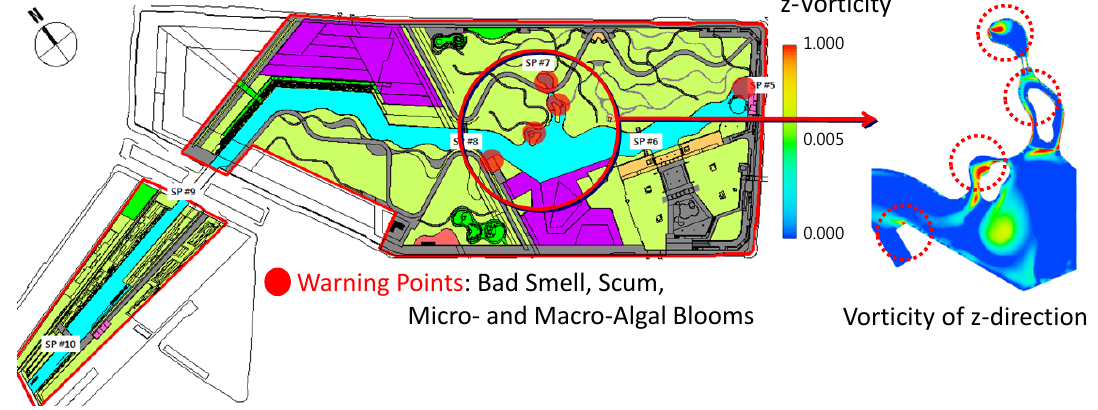
Figure 9. Warning points of algal blooms in the canal and vorticity of the z -direction using FLOW-3D.